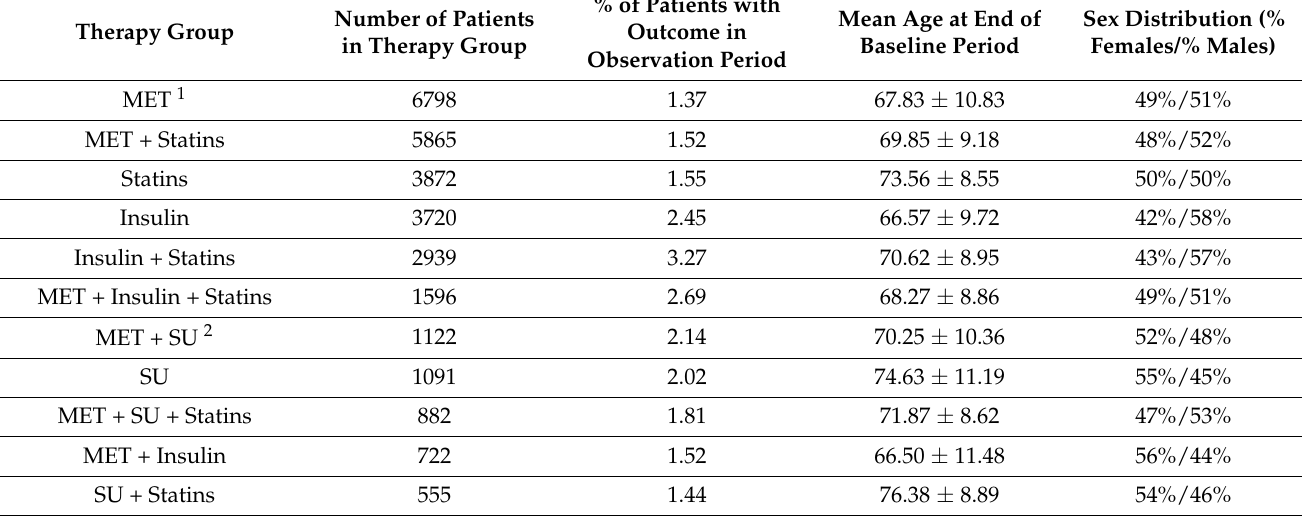
Table 1. Baseline table. All valid therapy groups with number of patients that fulfill the specified criteria and % of patients in therapy groups with observed outcome of pneumonia in 2016–2017. Additional info on mean ( ± STD) age and sex distribution in therapy groups and